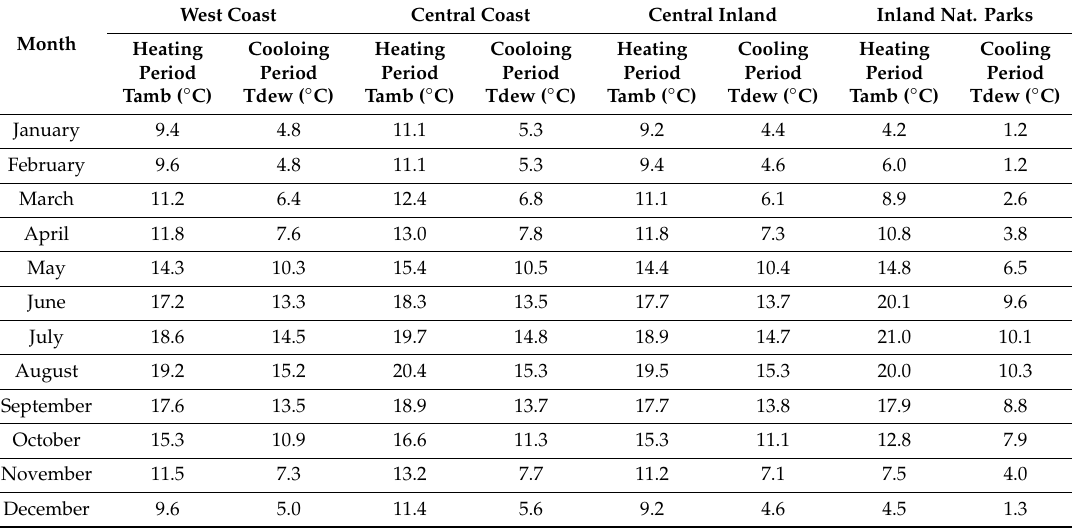
Table 7. Ambient and dew point temperatures (monthly average from hourly